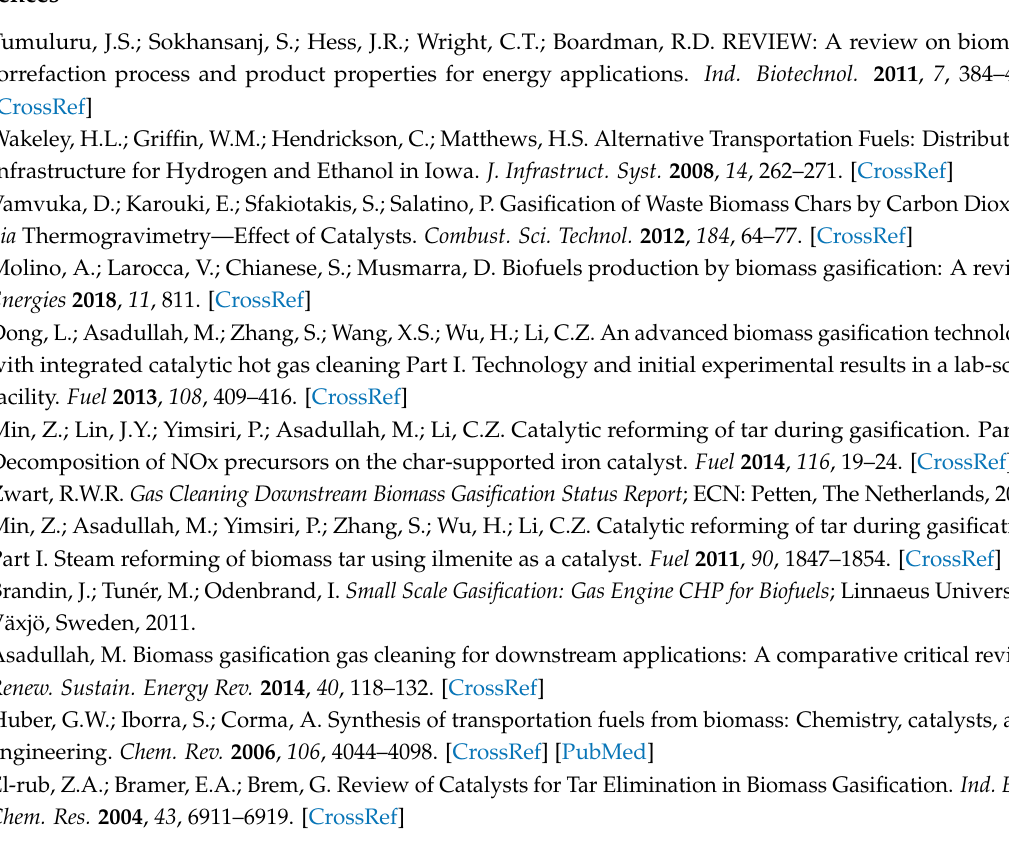
Table S1. MFC carbonization experimental conditions and CAGs textural